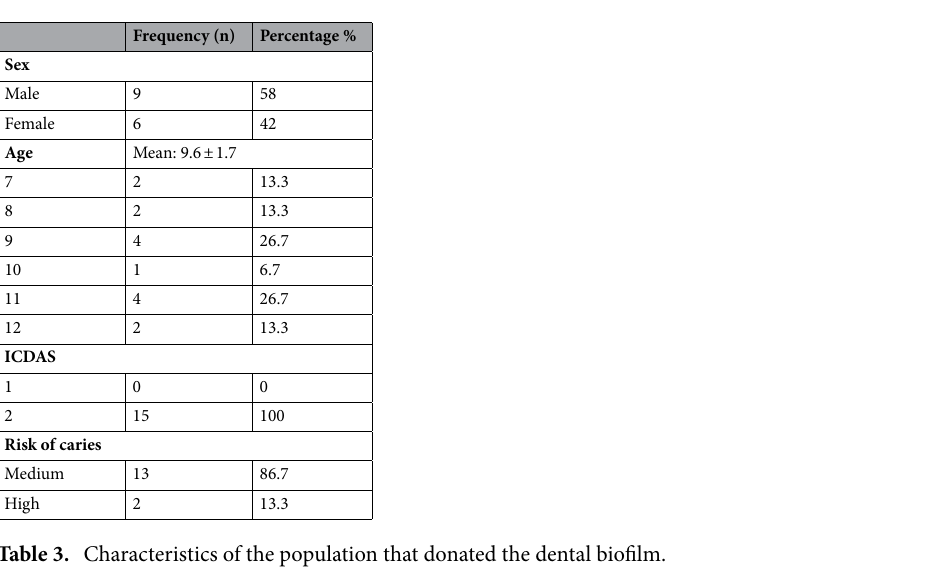
Figure 3. Inhibition of S . mutans 25175 and pH reduction. ( a ) Relationship between the sugar concentration announced on labels of analyzed foods and S . mutans 25175 inhibition. ( b ) Relationship between the sugar concentration announced on labels of analyzed foods and the reduction of pH in the medium. ( c ) Relationship between S . mutans 25175 inhibition and the sugar concentration of the foods selected for the next phase of the study. ( d ) Relationship between the reduction of pH in the medium and the sugar concentration of the foods selected for the next phase of the study. Kruskal–Wallis test and Dunn’s test were used for multiple comparisons, *P < 0.05, **P < 0.01.